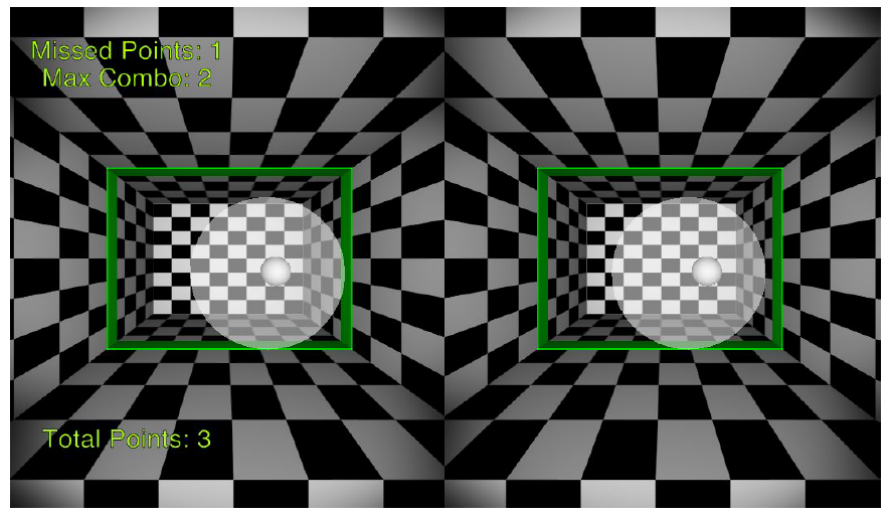
Figure 8. Relaxation